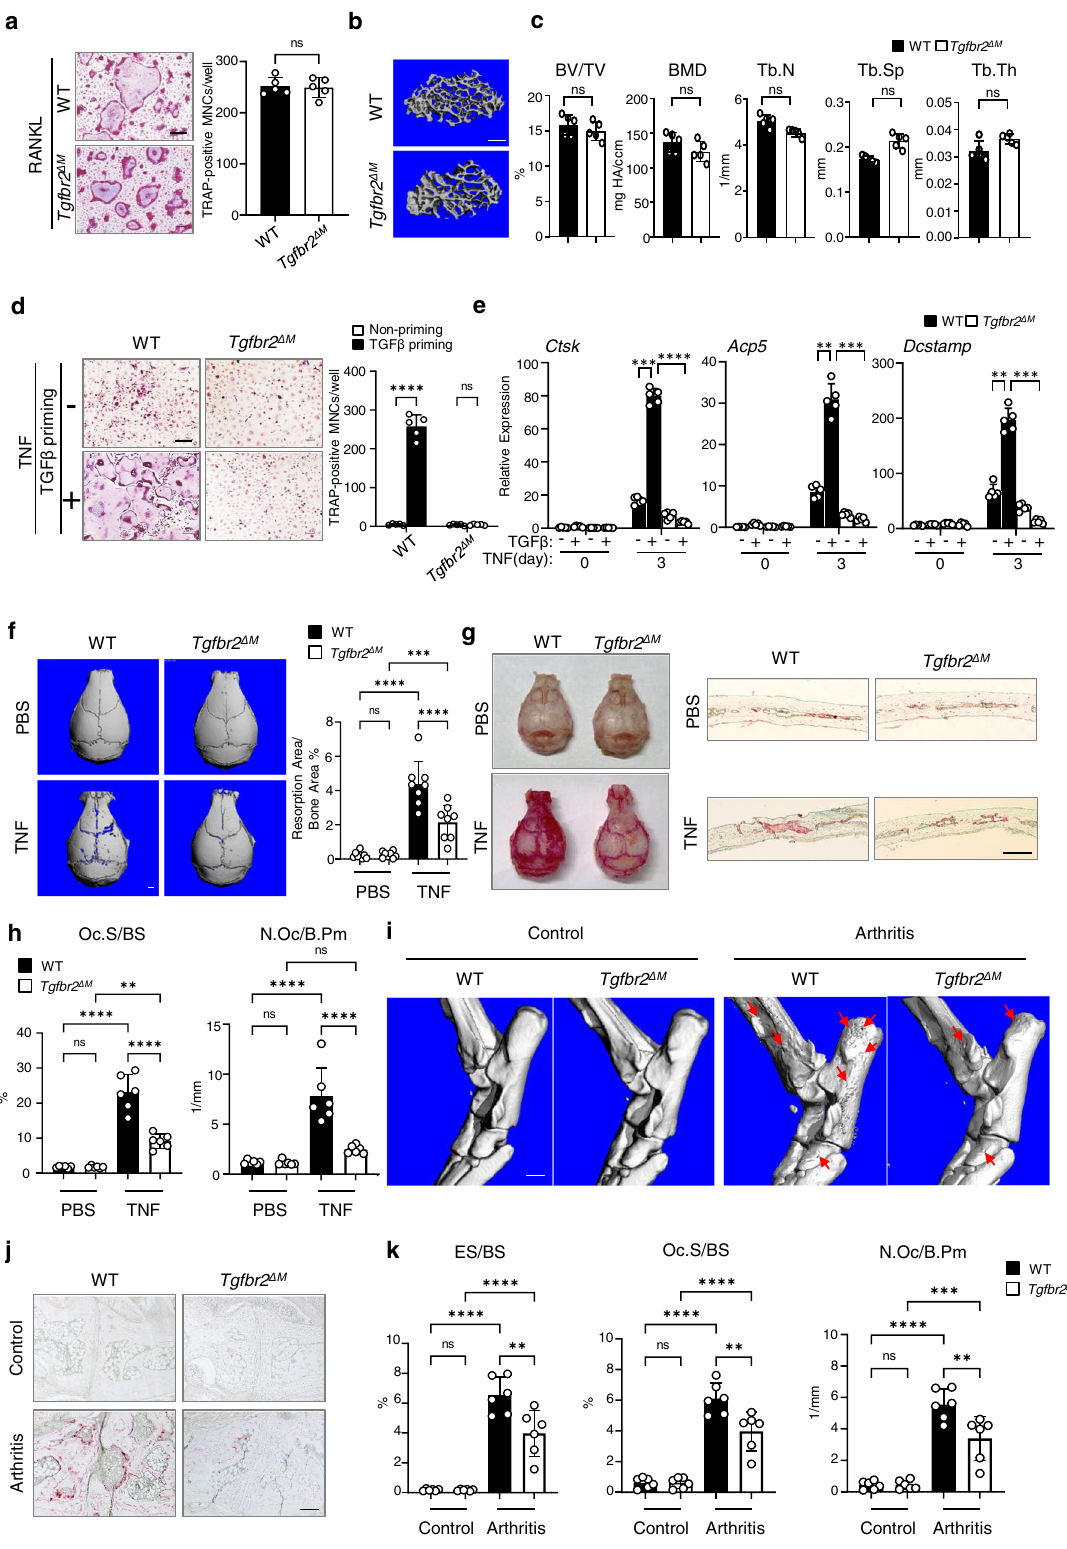
resorption sites (Fig. 2i – k) of the tarsal joints in the K/BxN arthritis model in comparison to the WT control mice that mimic TGF β priming condition. Joint swelling was sustained during the 14-day course of in fl ammatory arthritis, while suppressed bone erosion was observed in Tgfbr2 Δ M mice (Supplementary Fig. 10), suggesting that TGF β signaling has no signi fi cant effect